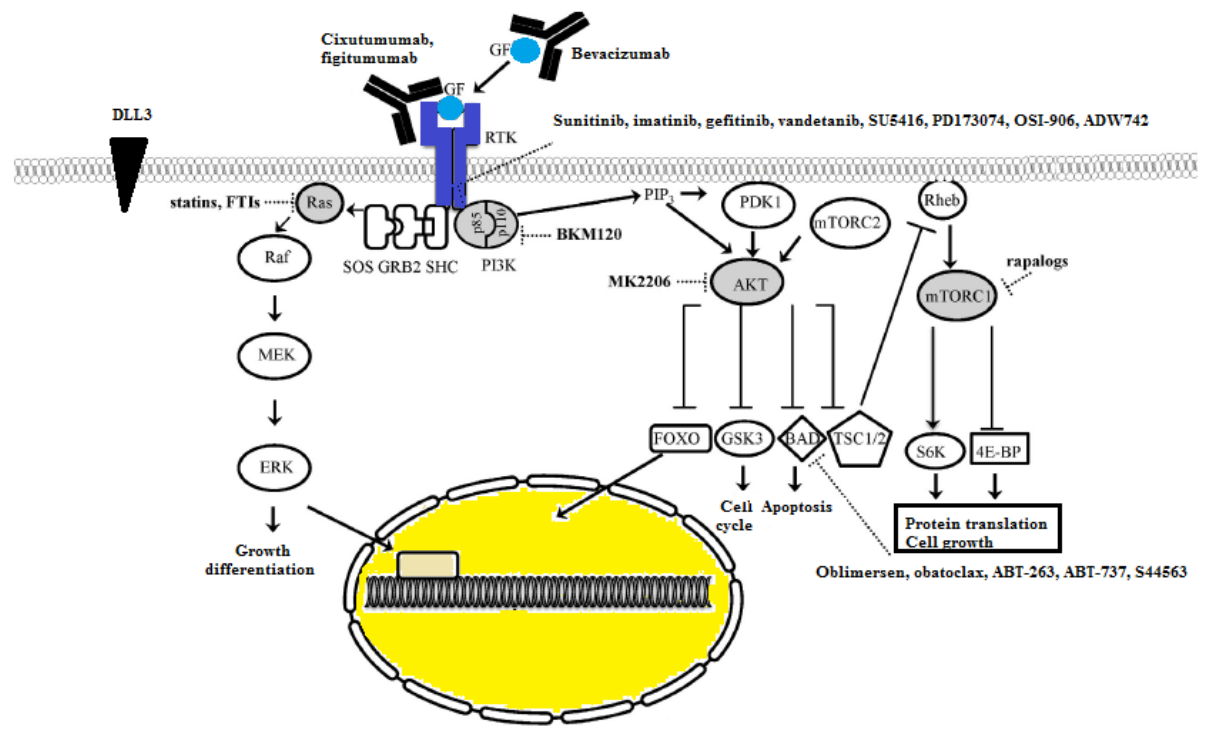
FIGURE 2 - Schematic representation of some classes of targeted drugs that have been evaluated in SCLC, including DLL3. The RTK/Ras/PAM pathway, its regulation by growth factor (GF) binding to receptor tyrosine kinases (RTKs) and the main downstream mediators activated are